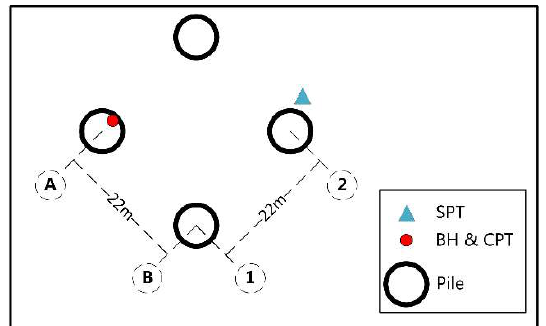
Figure 1. Layout of piles and in situ tests.